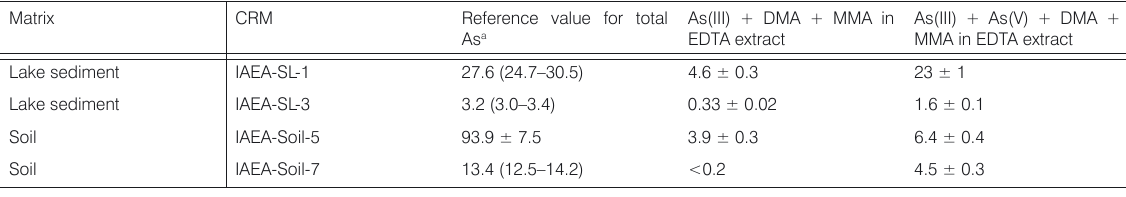
a 95% confidence interval in